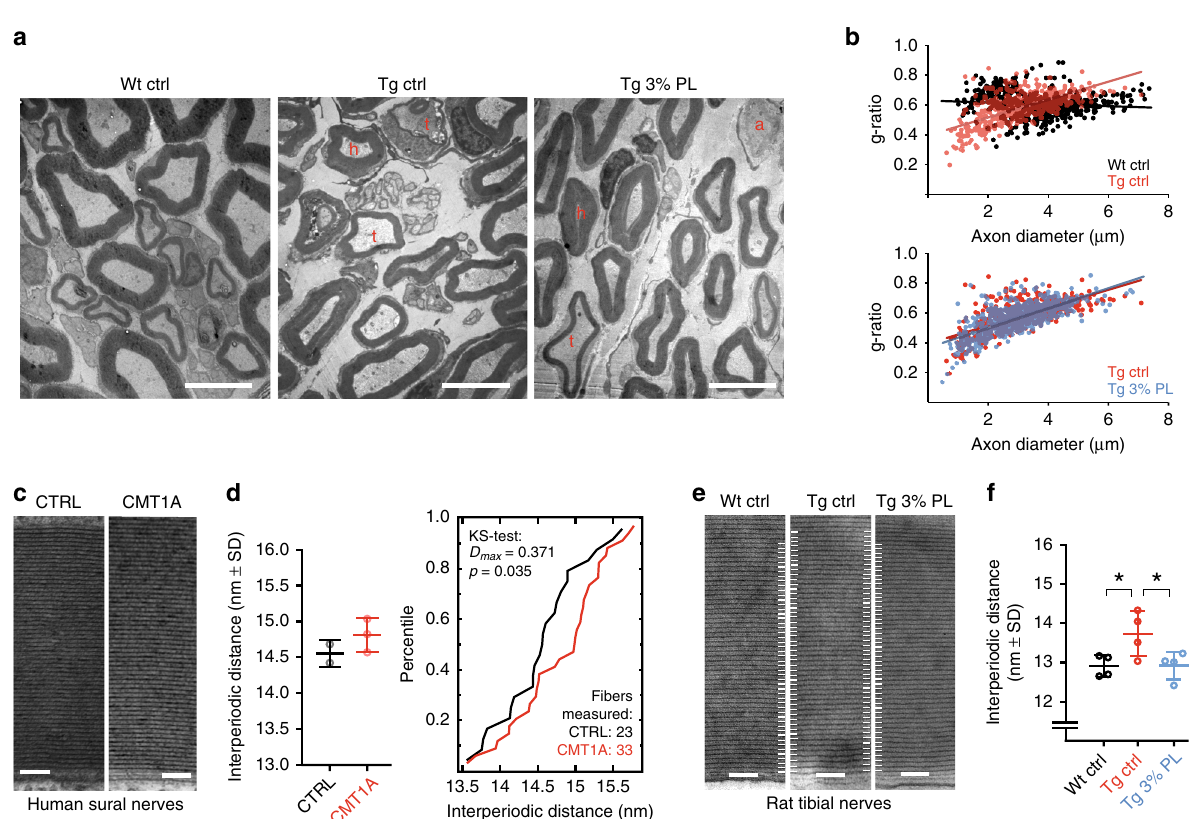
Fig. 4 Phospholipid therapy in CMT rats improves perturbed myelin ultrastructure. a Representative electron micrographs of tibial nerve cross sections from a Wt ctrl (left), Tg ctrl (middle), and Tg rat treated with 3% PL (right) at P112. CMT rats typically display numerous hypermyelinated (h), thinly myelinated (t), and amyelinated (a) fi bers. Scale bar: 5 µ m b Electron microscopic analysis of the myelin sheath thickness by g -ratio measurement shows a steepening in the regression line in Tg ctrl rats (red, n = 4), when compared with Wt control rats (black, n = 5, upper panel). Treatment with 3% PL